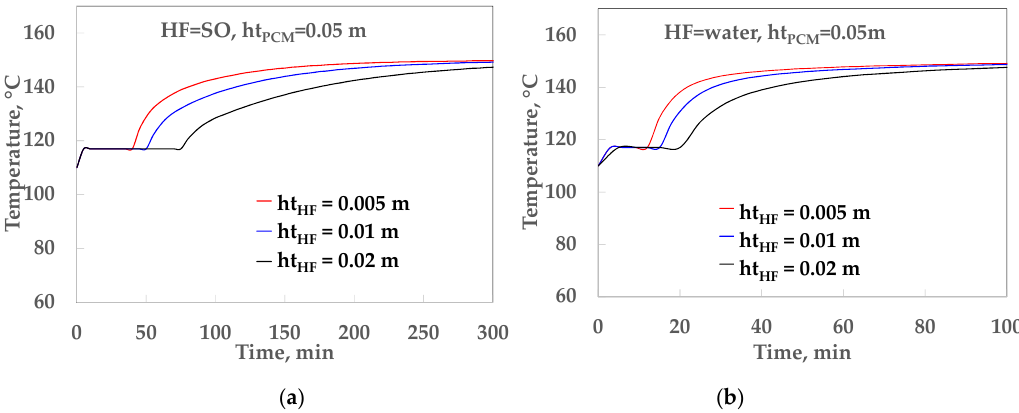
Figure 9. Temperature profile over time for a height of PCM = 0.05 m using ( a ) SO and ( b ) water.